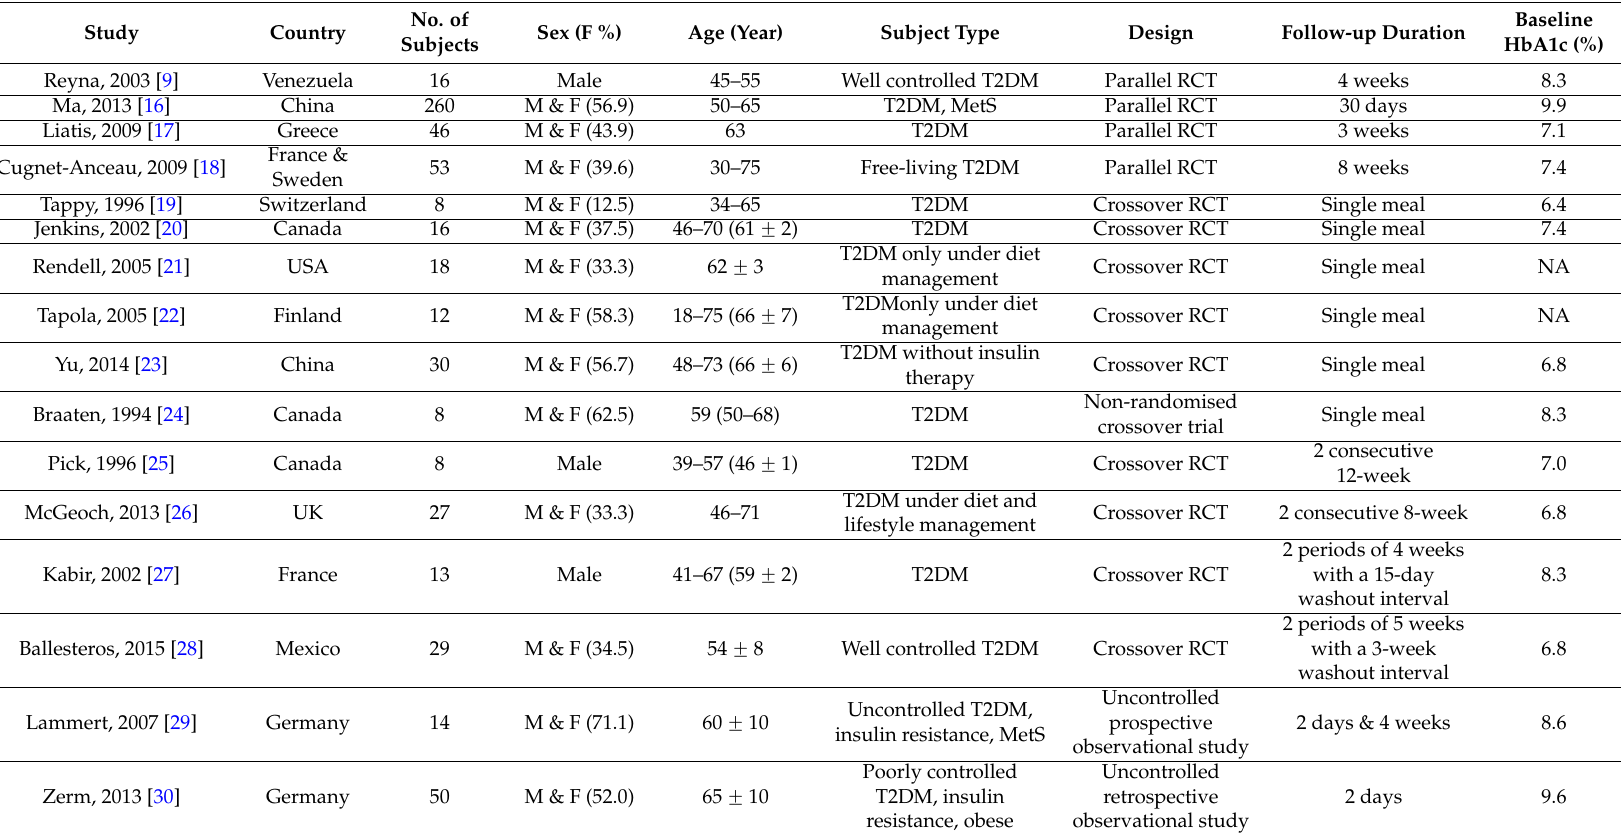
Table 1. Baseline characteristics of studies